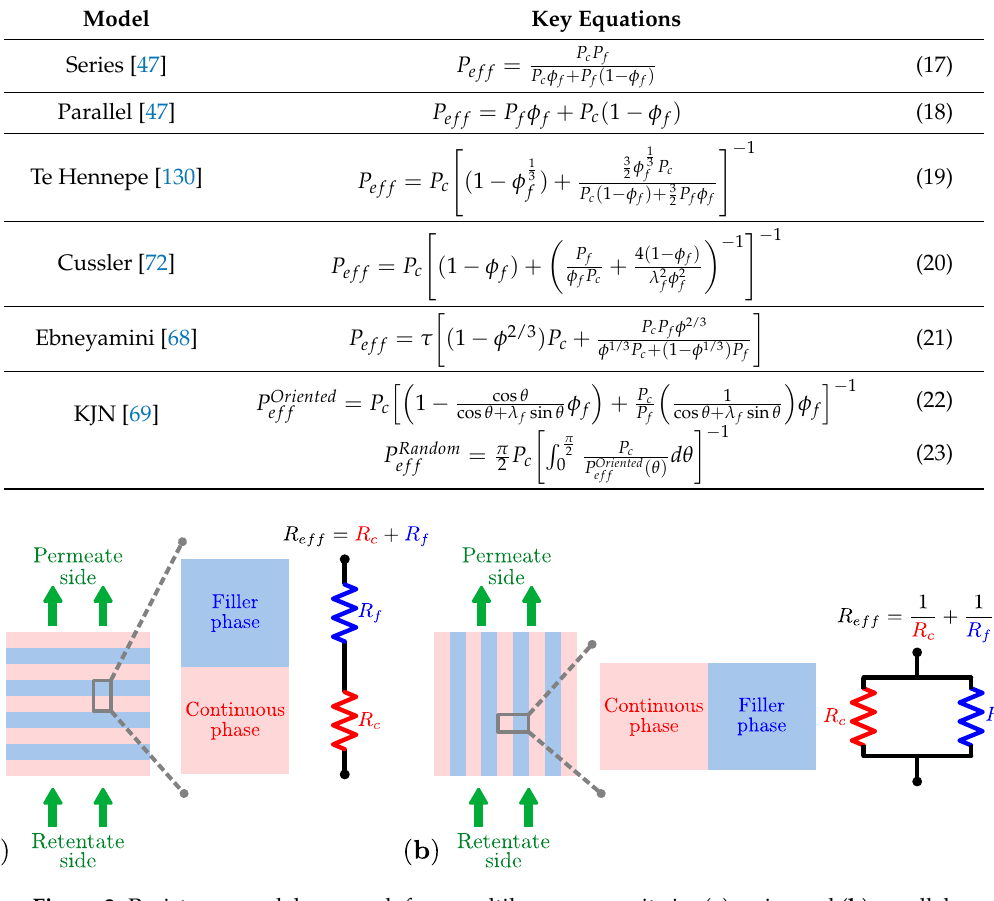
Figure 2. Resistance model approach for a multilayer composite in: ( a ) series and ( b ) parallel.